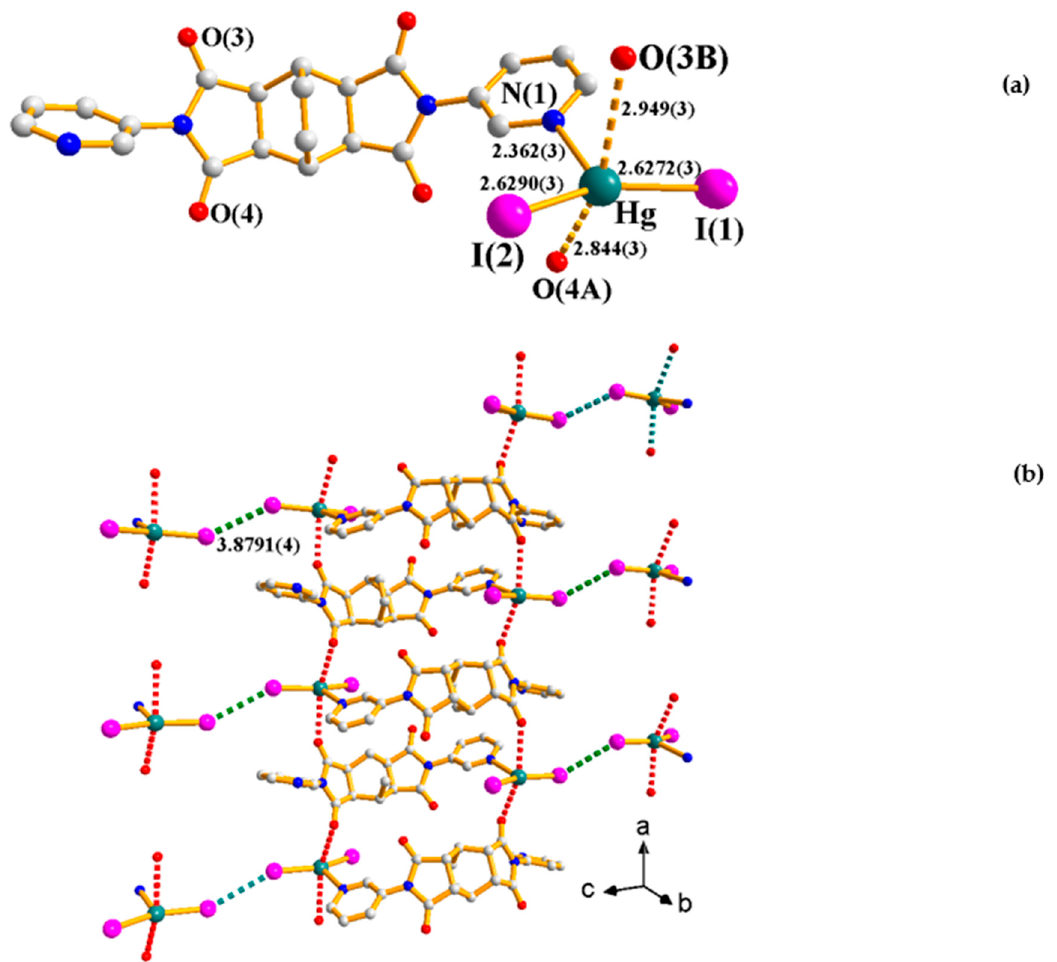
Figure 4. ( a ) Coordination environment of Hg(II) ion in 3 . Symmetry transformations used to generate equivalent atoms: (A) − x + 1, − y + 1, − z + 2; (B) − x + 2, − y + 1, − z + 2. ( b ) A drawing showing the 2D supramolecular layer.